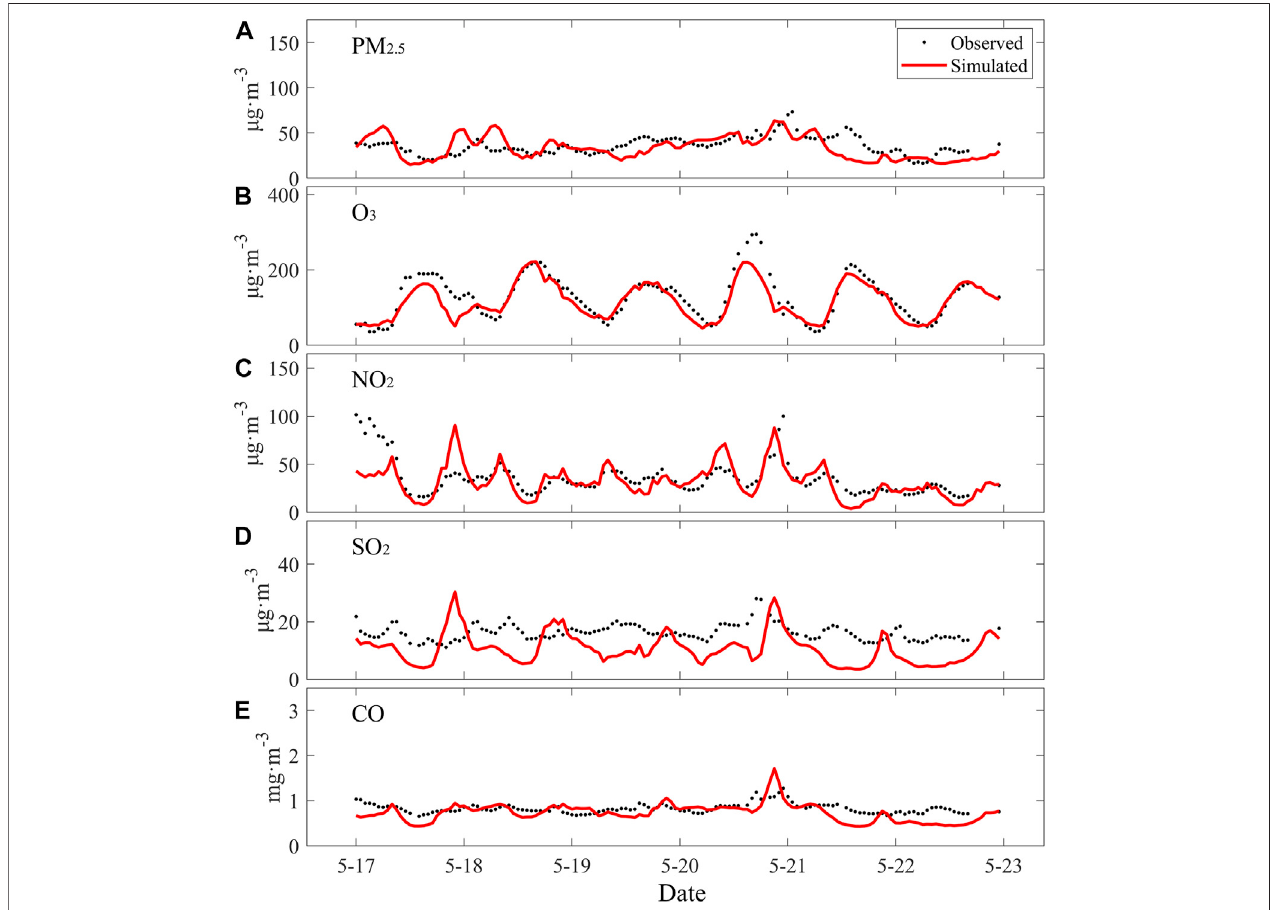
FIGURE 2 | The same as Figure 1 , but for air pollutants including (A) PM 2.5 , (B) O 3 (C) NO 2 , (D) SO 2 and (E)